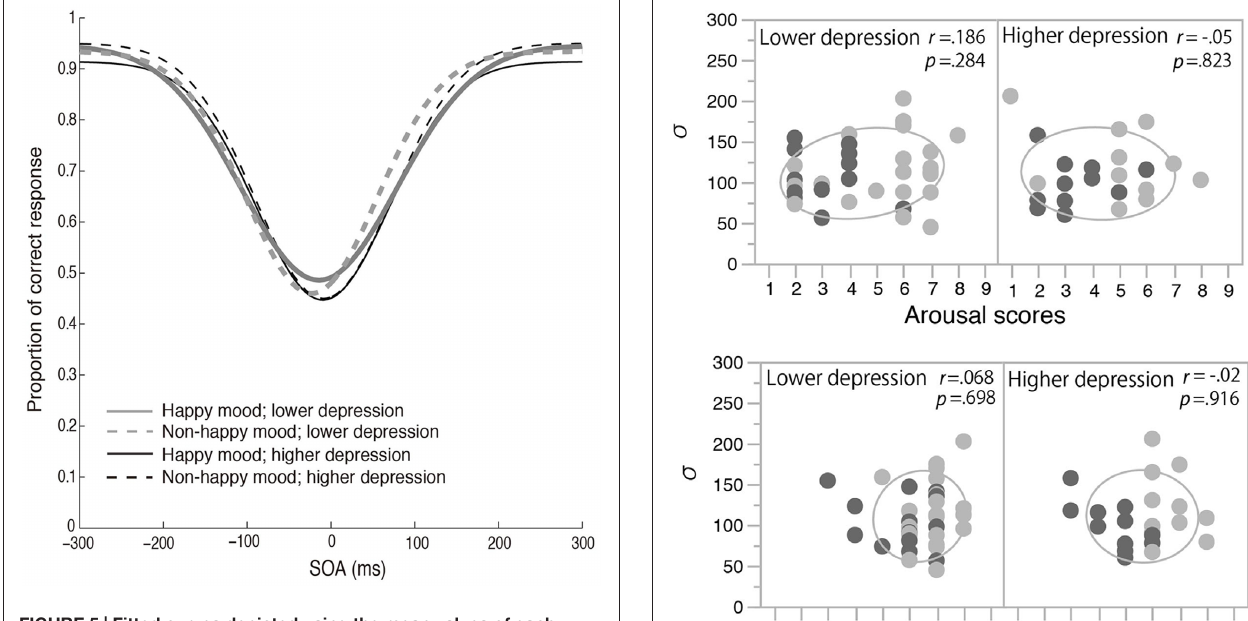
FIGURE 5 | Fitted curves depicted using the mean values of each parameter ( σ , µ , pinc and pbase ) that were derived from the Gaussian fitting for the happy and non-happy conditions in the two depression groups in Experiment 2.